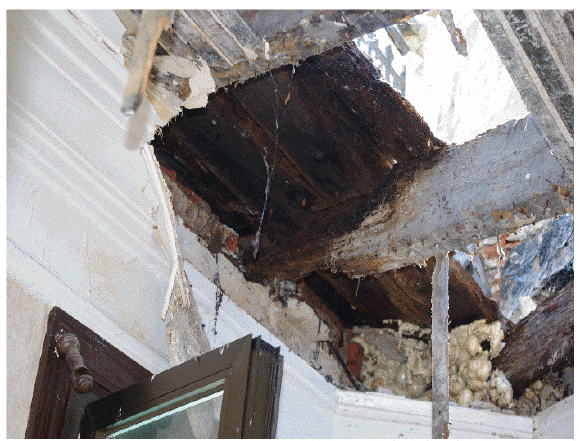
Figure 1. Wooden beam-end degradation sample in a self-evaluated case.